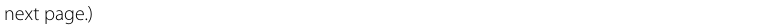
2, 0, 2, and 4 stop) and 6 thresholding manipulations ( − + + are misclassified as sky pixels are shown in red; sky and grey pixels which are misclassified as canopy pixels are blue; sky and grey pixels which are correctly classified as sky are white; canopy and grey pixels which are correctly classified as canopy are black. These CHPs were taken for a model canopy with gap fraction of 0.25 and SCB length per unit area of 0.4 mm mm − 1 (i.e. side length of square opening of 2.5 mm). The diameter of the original circular images of these model CHPs is 2098 pixels, and the image dimension of cropped binary images shown in this figure is 177 by 177 pixels. Greyness histograms of these CHPs presented in this figure are shown in Fig. 7. The unit of the exposure manipulation,